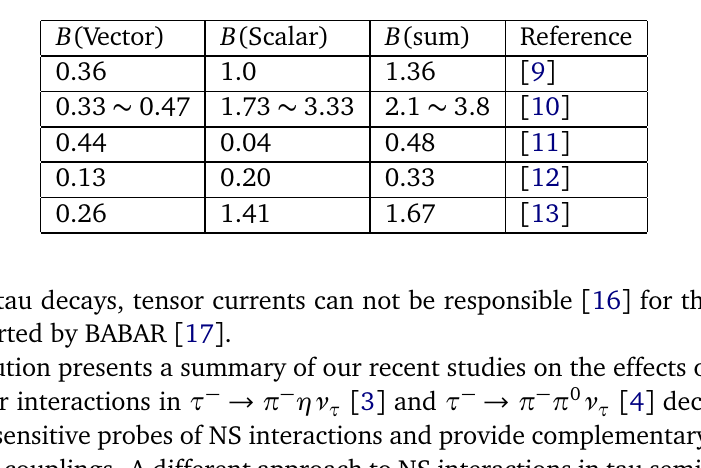
Table 1: Predicted branching ratios (in 10 − 5 units) for τ − → π − ην τ decays induced by isospin breaking π 0 − η mixing. Contributions of vector and scalar form factors to the branching ratios (and their sum) are shown